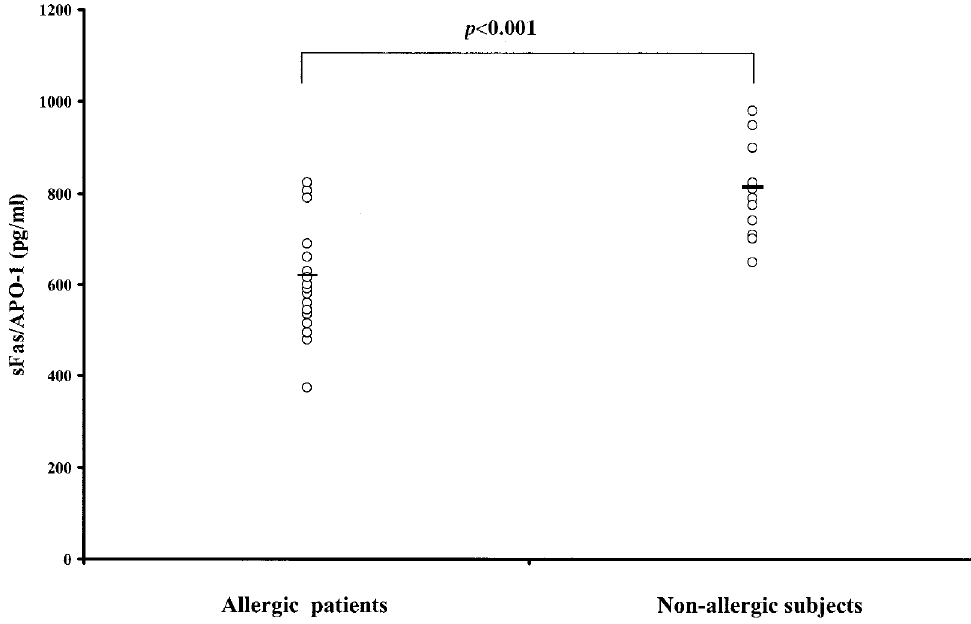
FIG. 4. Serum levels of sFas/APO-1 in an allergic and non-allergic group. (–) mean value.